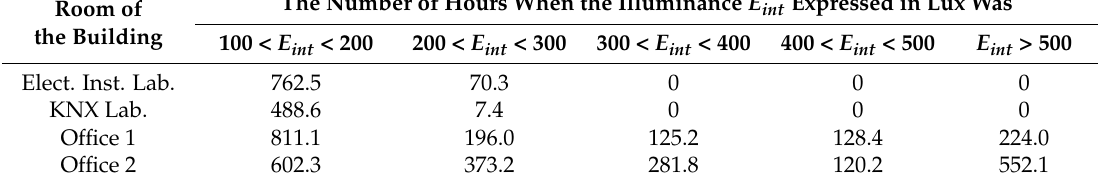
Table 4. The number of hours when the illuminance level exceeded the specified